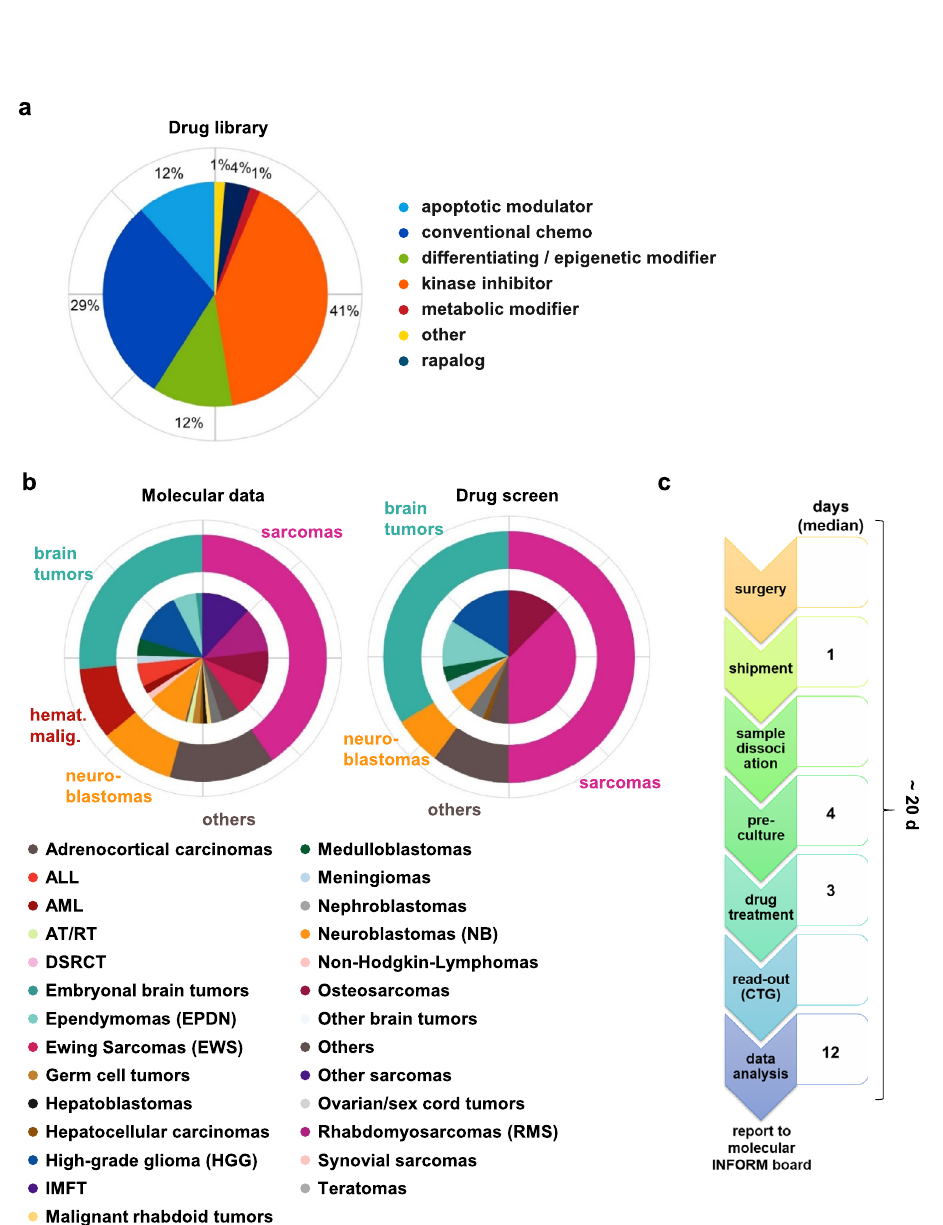
Fig. 5 DSP pipeline and cohort overview. a Composition of the core drug library, consisting of 75 – 78 drugs. b Cohort overview. Left: Tumor diagnoses of fresh frozen material used for molecular analysis through NGS ( n = 1642). Right: Tumor diagnosis distribution in the present cohort of INFORM samples with vital tissue submission. The pie diagrams represent the distribution of the indicated diagnoses within the whole cohort. The outer circles represent broad tumor categories: sarcomas (magenta), brain tumors (green), hematological malignancies (hemat. malig., red), neuroblastomas (orange) and others (brown). The inner circle represents the more detailed tumor diagnoses within each category, as explained in the color code below the pie charts. c Timeline from surgery to drug report for QC-passed full screens and where myo fi broblastic tumor, NB neuroblastoma, RMS rhabdomyosarcoma, QC quality